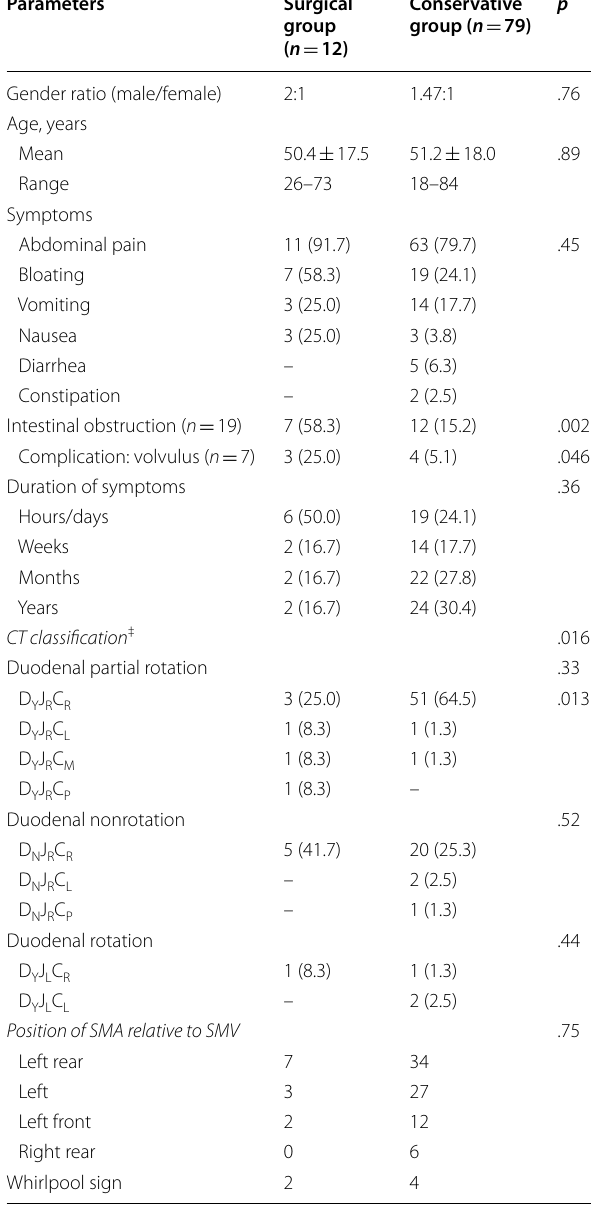
Table 3 Clinical and CT characteristics of surgical and conservative